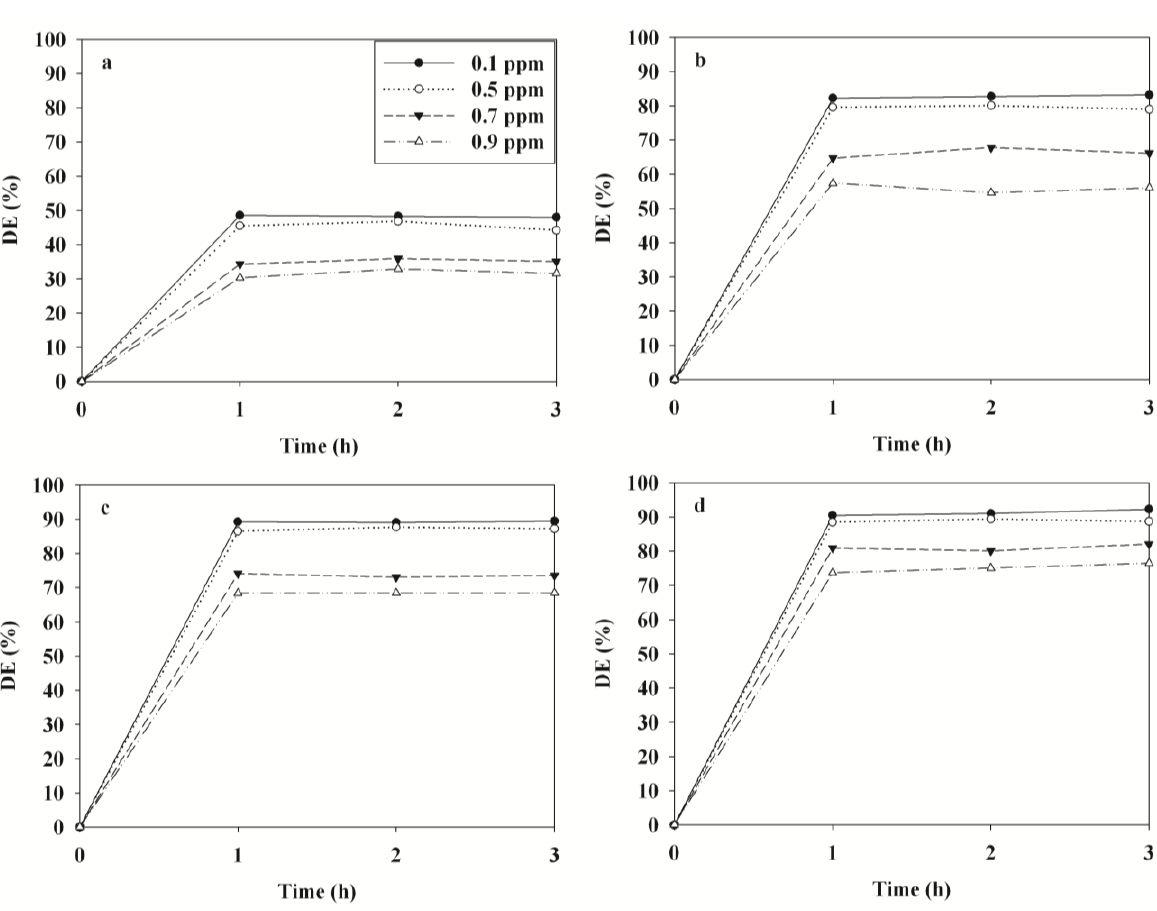
Figure 7. Degradation efficiencies (DE) of ( a ) benzene; ( b ) toluene; ( c ) ethyl benzene; ( d ) o-xylene determined using TNTUCF-10 according to varying input concentrations (0.1, 0.5, 0.7, and 0.9